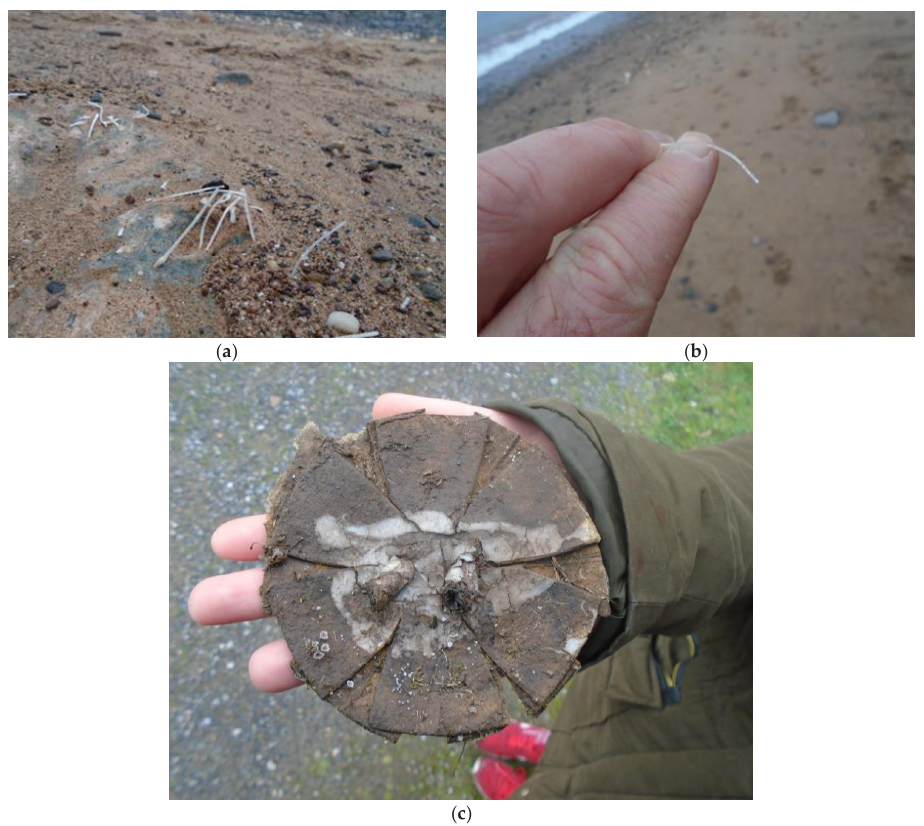
Figure 25. Red sandstone, limestone.